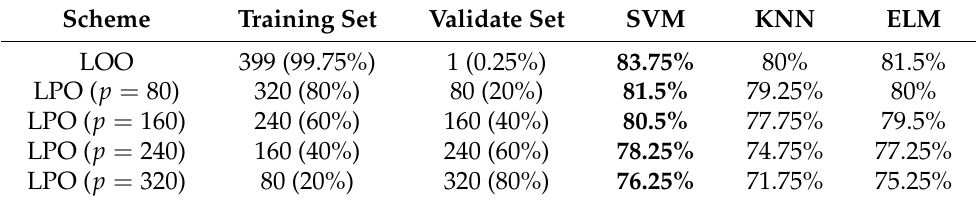
Table 3. Comparative results, in terms of ACC G , between the three classifier versions (SVM, KNN, and ELM) of the method UPER using four Leave-p-Out (LPO) cross-validation schemes.